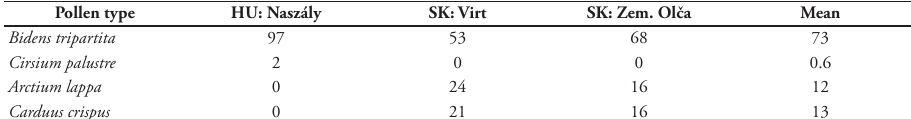
Table 1. Proportions (in %) of pollen types in three samples from nests of Pseudoanthidium tenellum . Pollen type